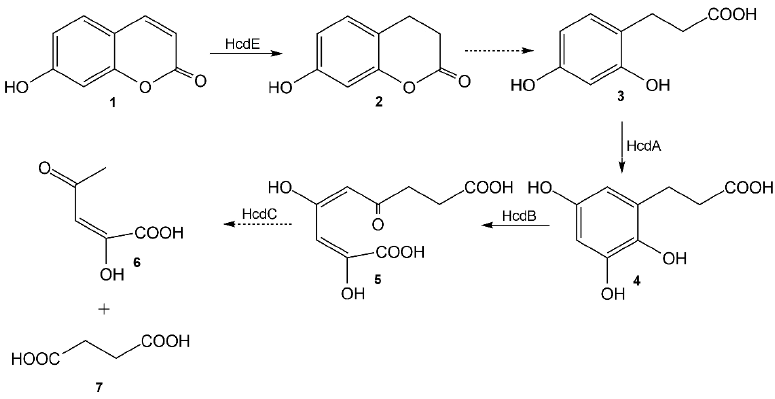
Figure 9. The proposed catabolic pathway of 7-hydroxycoumarin in Pseudomonas sp. 7HK4 bacte- ria. 1 — 7-hydroxycoumarin; 2 — 7-hydroxy-3,4-dihydrocoumarin; 3 — 3-(2,4-dihydroxyphenyl)pro- 1 —7-hydroxycoumarin; 2 —7-hydroxy-3,4-dihydrocoumarin; 3 —3-(2,4-dihydroxyphenyl)propionic acid; pionic acid; 4 — 3-(2,3,5-trihydroxyphenyl)propionic acid; 5 — (2 E ,4 E )-2,4-dihydroxy-6-oxonona-2,4- 4 —3-(2,3,5-trihydroxyphenyl)propionic acid; 5 —(2 E ,4 E )-2,4-dihydroxy-6-oxonona-2,4-dienedioic acid; dienedioic acid; 6 — ( E )-2-hydroxy-4-oxopent-2-enoic acid; 7 — succinic acid; HcdA — 3-(2,4-dihy- droxyphenyl)propionic acid 1-monooxygenase; HcdB — 3-(2,3,5-trihydroxyphenyl)propionic acid 6 —( E )-2-hydroxy-4-oxopent-2-enoic acid; 7 —succinic acid; HcdA—3-(2,4-dihydroxyphenyl)propionic 1,2-dioxygenase; HcdC — putative (2 E ,4 E )-2,4-dihydroxy-6-oxonona-2,4-dienedioic acid hydrolase; acid 1-monooxygenase; HcdB—3-(2,3,5-trihydroxyphenyl)propionic acid 1,2-dioxygenase; HcdC— HcdE — 7-hydroxycoumarin reductase. The dashed arrows indicate the hypothetical reactions. putative (2 E ,4 E )-2,4-dihydroxy-6-oxonona-2,4-dienedioic acid hydrolase; HcdE—7-hydroxycoumarin reductase. The dashed arrows indicate the hypothetical